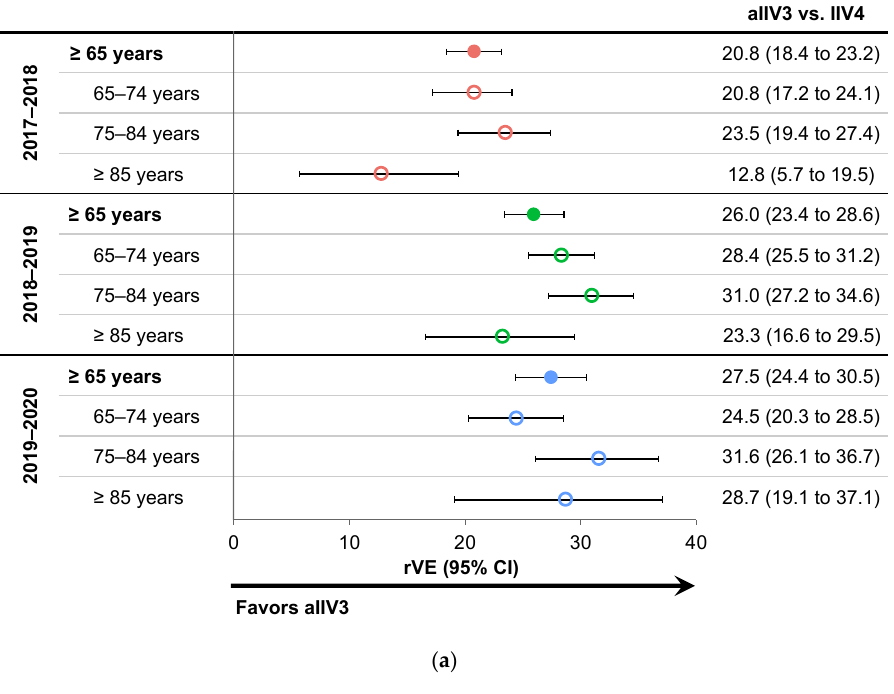
(b) Figure 3. Relative vaccine effectiveness (rVE) of adjuvanted trivalent inactivated influenza vaccine (aIIV3) vs. comparators for the prevention of influenza related medical encounters during the three influenza seasons between 2017 and 2020 in subjects ≥ 65 years of age and by age subgroups [22,24] . ( a ) aIIV3 vs. egg-based quadrivalent inactivated influenza vaccine (IIV4e); ( b ) rVE for aIIV3 vs. high- dose trivalent inactivated influenza vaccine (HD-IIV3). CI, confidence interval.